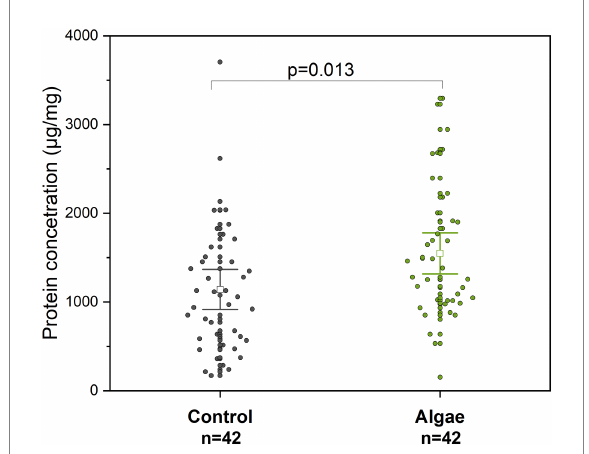
FIGURE 6 Protein concentration in extracts from adult bee abdomens.